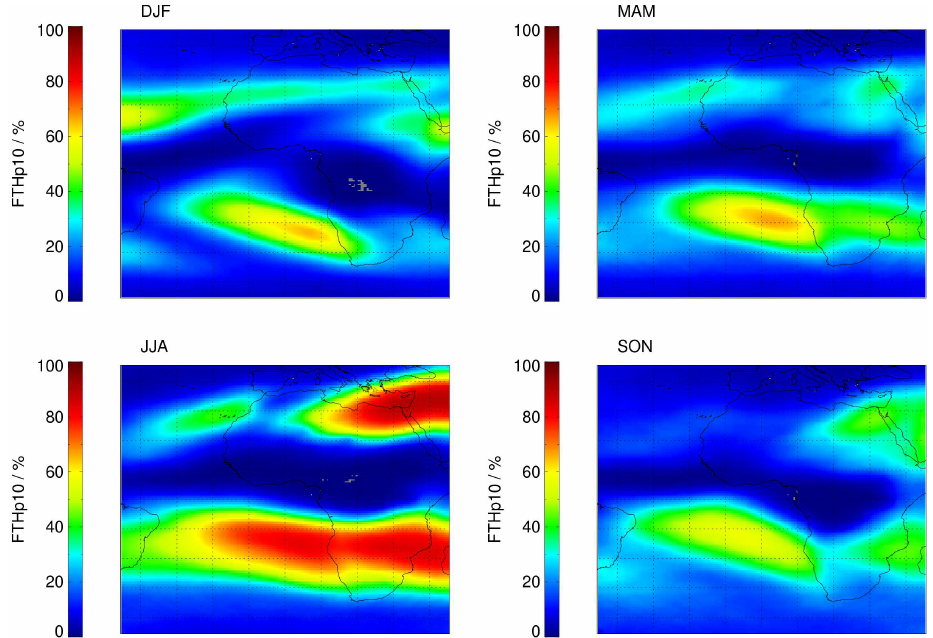
Figure 7. Same as Fig. 4 but for the frequency of occurrence of FTH <10% (FTHp10). Areas where only a small number of observations are valid are shown in grey.